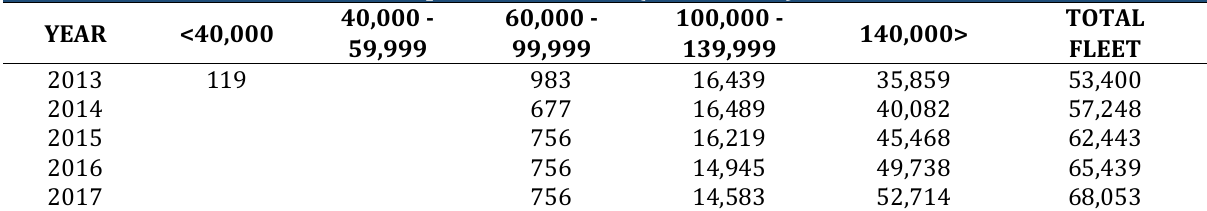
Table 2: LNG Carrier Fleet Development ‘000 bcm